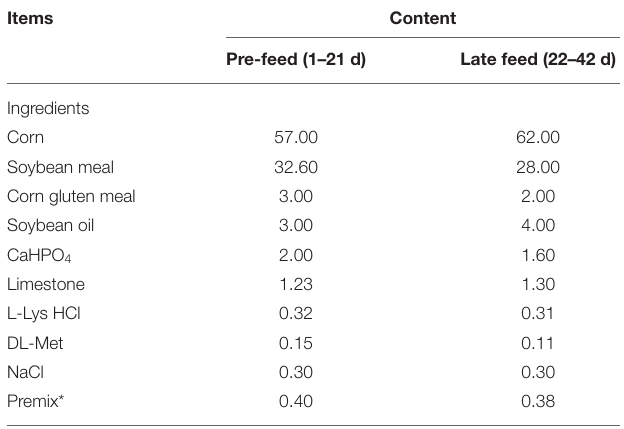
TABLE 1 | Ingredients and nutritional levels of elemental diet (air-dry basis) (%). Items